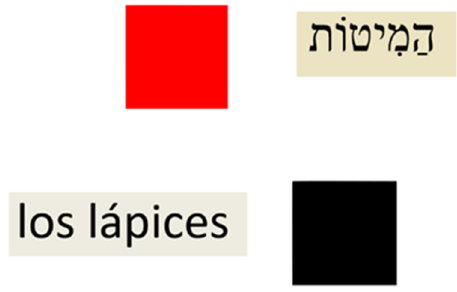
Figure 3. Agreement elicited production task (EPT) experimental trial in each target language.